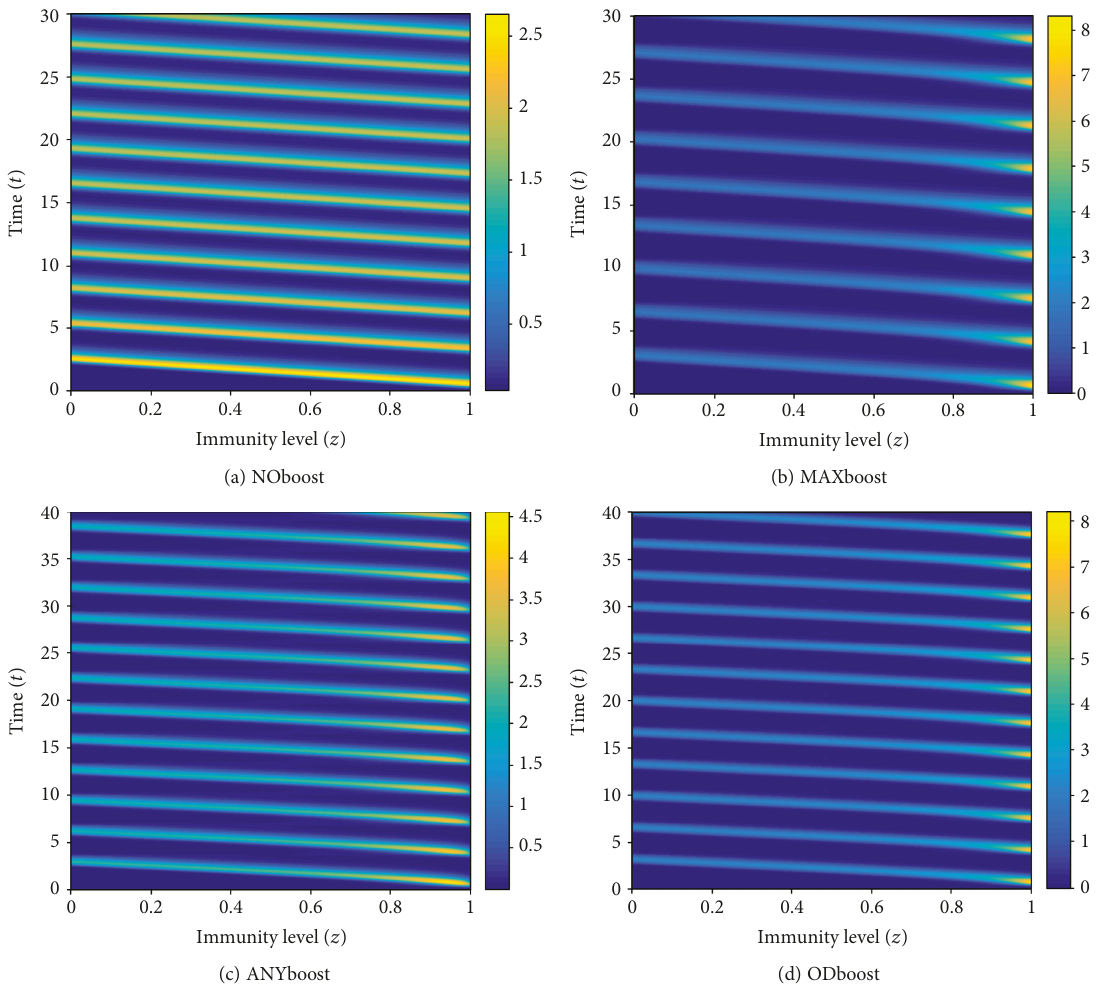
Figure 9: Contour plot of the r solution for di ff erent boosting mechanisms. (a) Waning immunity, no boosts. (b) Boost to maximal level of immunity. (c) Uniform probability of boosting to any higher immunity level. (d) Nonlinear boosting function as in Figure